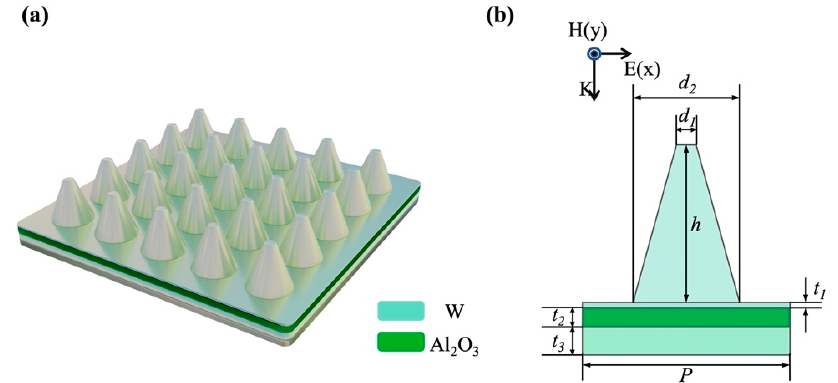
Figure 1. Schematic diagram of the MSSA: ( a ) three-dimensional schematic of the MSSA, ( b ) two-dimensional cross-section schematic of the unit cell structure.